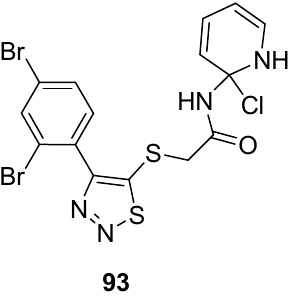
Figure 5. Anti-HIV activity of 5-(2,4-dibromophenyl)-1,2,3-thiadiazole 93 .